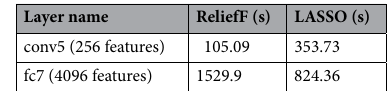
Table 9. Time of feature selection using the ReliefF and LASSO